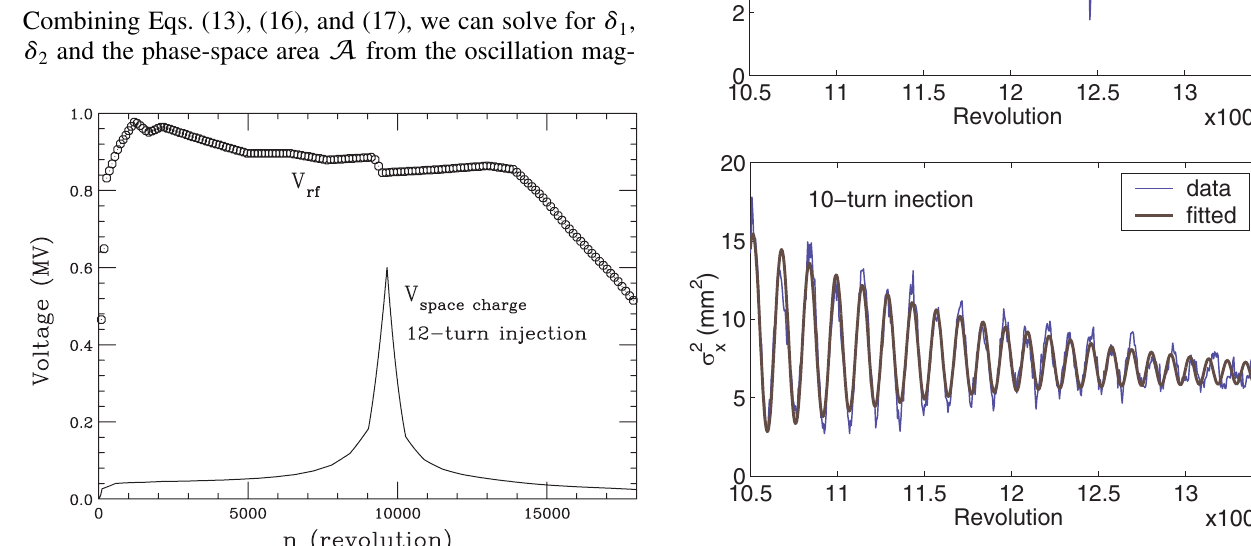
(solid) and spchg